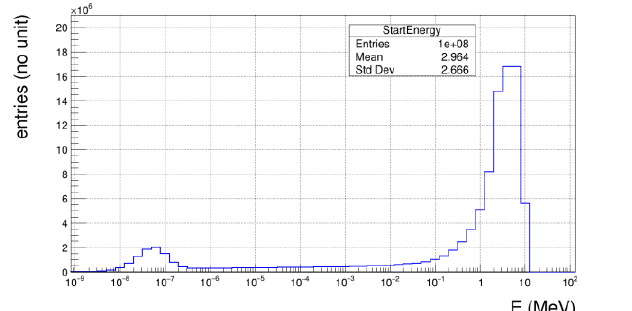
Fig. 2. Energy spectrum (in MeV) of the moderated Am/Be